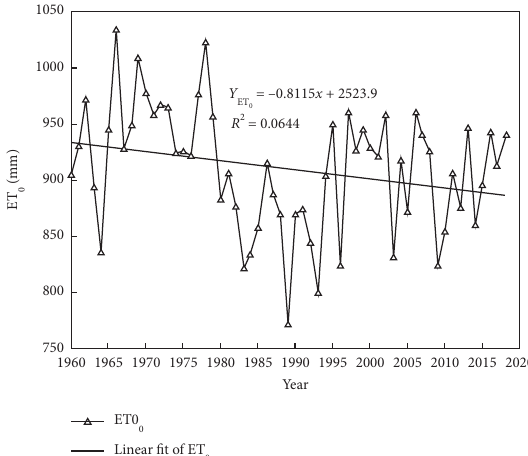
Figure 3: The variation in ET0 in the Yue River watershed during 1960–2018.